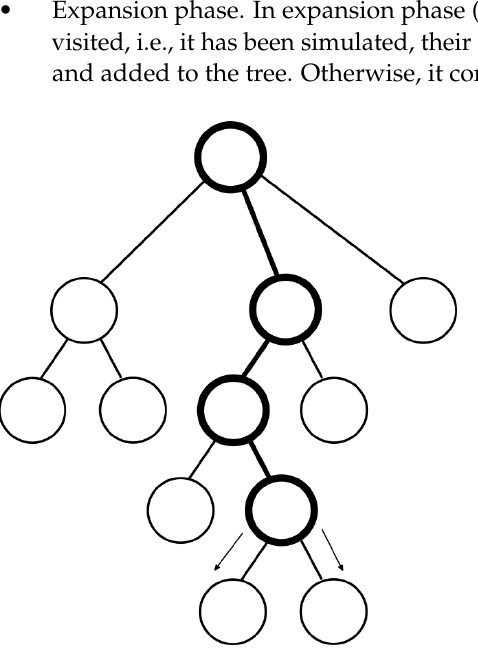
Figure 3. Expansion phase in MCTS. Algorithm 2 Expansion